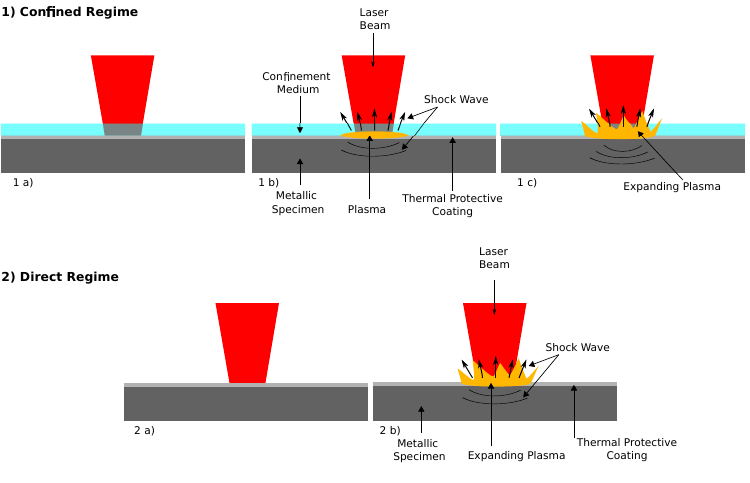
Figure 1. Principle of LSP